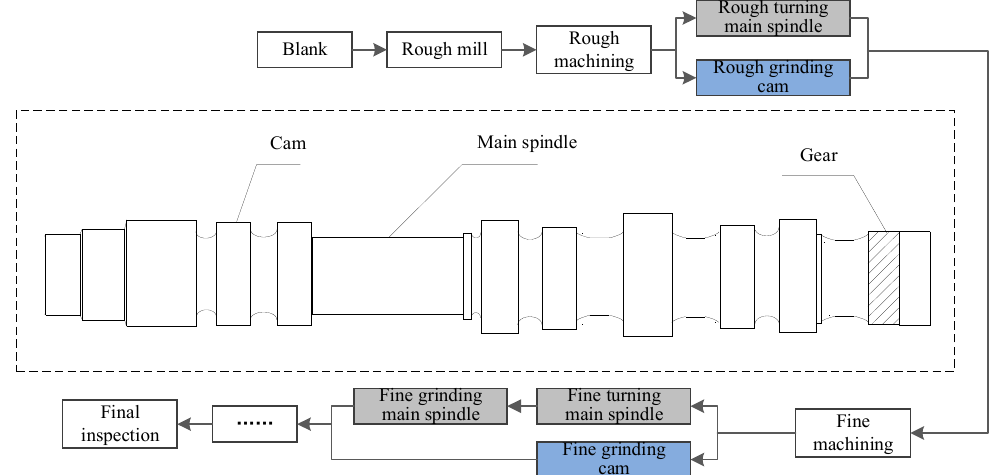
Figure 6. Camshaft structure diagram and manufacturing process.